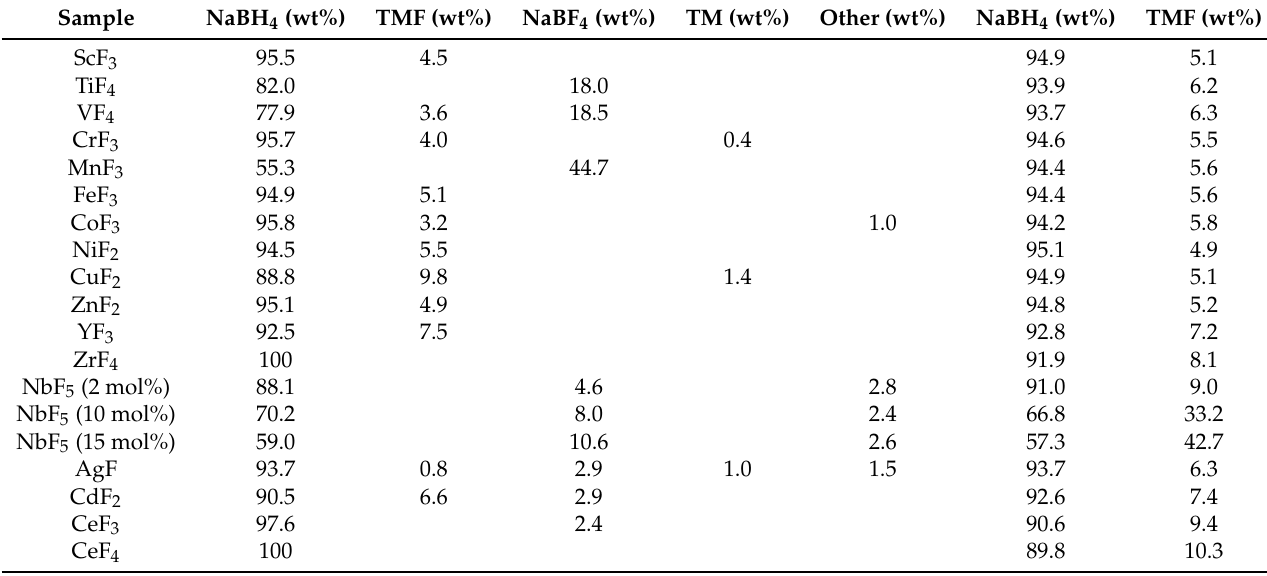
Table 1. Composition of the samples before and after ball milling. The first 5 columns show the composition of the ball-milled samples as evaluated by EVA. The two last columns are the calculated wt% of the original physical mixture before ball